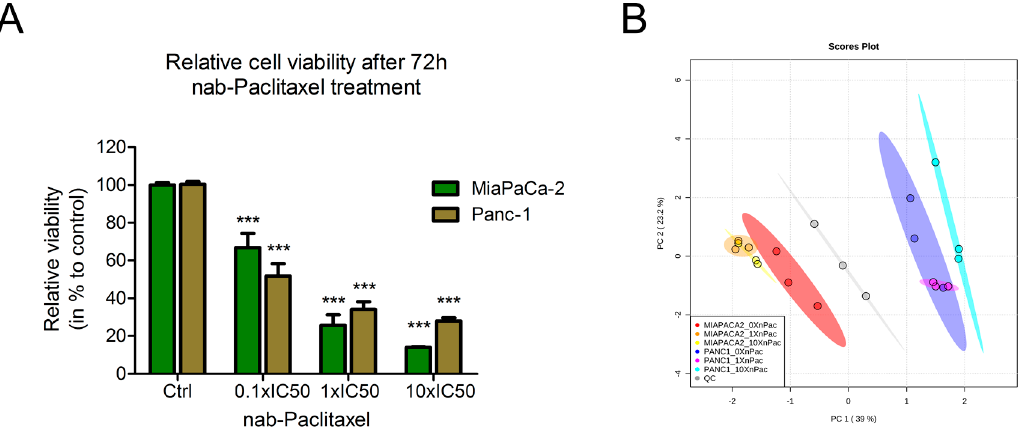
Figure 1. ( A ) Relative viability of nab-paclitaxel treated cells with 0.1 × IC50, 1 × IC50 and 10 × IC50 concentrations for 72 h. Control (Ctrl) treatment describes vehicle application. The viability of cells was calculated in percent relative to control treatment. Bar charts display mean ± standard error of the mean ( n = 9). A p -value of p < 0.05 was considered as statistically significant (*** indicates p < 0.001). ( B ) Principal component analysis of endometabolome GC / MS profiling of PDAC cell lines upon treatment with nab-paclitaxel. 0 × nPac: untreated control, 1 × nPac: IC50 concentration, 10 × nPac: ten-fold IC50 concentration. Quality control samples, consisting of equal volumes of all samples, were included into the analysis. Analysis was performed after 72 h treatment. n = 3.